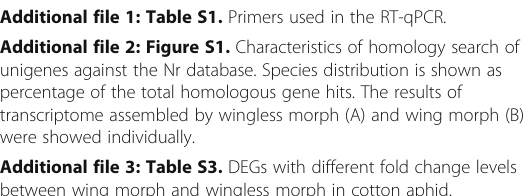
Additional file 3: Table S3. DEGs with different fold change levels between wing morph and wingless morph in cotton aphid.